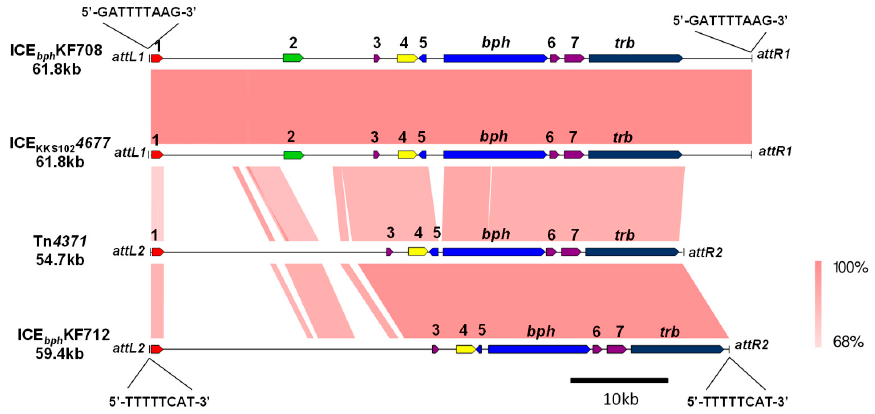
Figure 8. Organization of ICE bph KF708 and ICE bph KF712 in comparison to ICE KKS102 4677 and Tn 4371 . attL1 and attR1 represent integration sites for the ICE bph KF708 and ICE KKS102 4677. attL2 and attR2 represent integration sites for the Tn 4371 or ICE bph KF712. 1, integrase ( int ) gene; 2, putative arsenate-resistant gene; 3, parA gene; 4, VirD2 component (relaxase); 5, transcriptional regulator bphS gene; 6, traR gene; and 7, traG gene. The shading in pink to red shows the identities (68–100%) of the gene clusters as indicated at the right bottom of the figure.